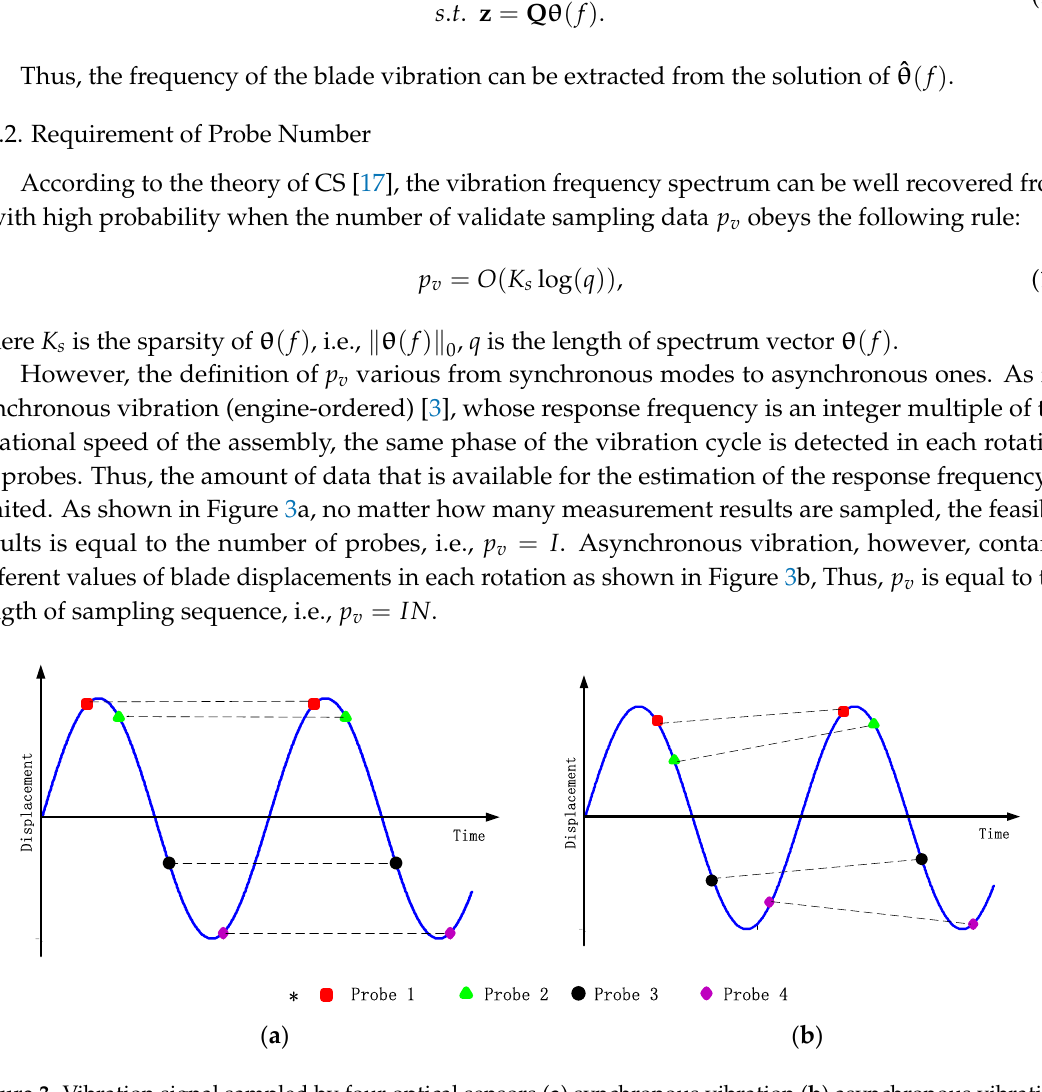
Figure 3. Vibration signal sampled by four optical sensors ( a ) synchronous vibration ( b ) asynchronous vibration.